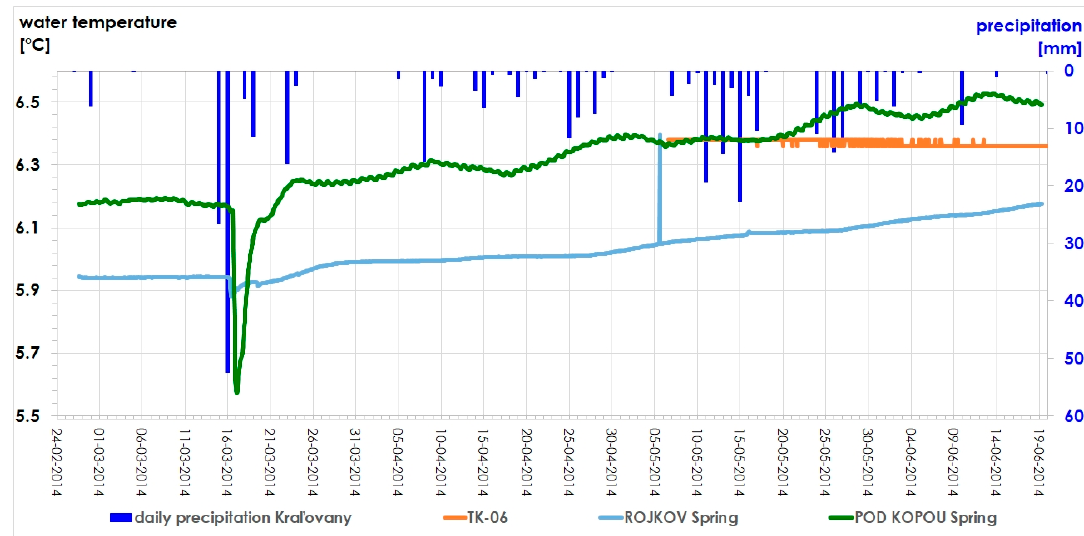
Figure 9. Daily precipitation in Kra ľ ovany and groundwater temperatures in the Rojkov and Pod Kopou Springs and the TK-06 borehole with visible influence of 15.03.2014–16.03.2014 precipitation event of water temperature in springs.